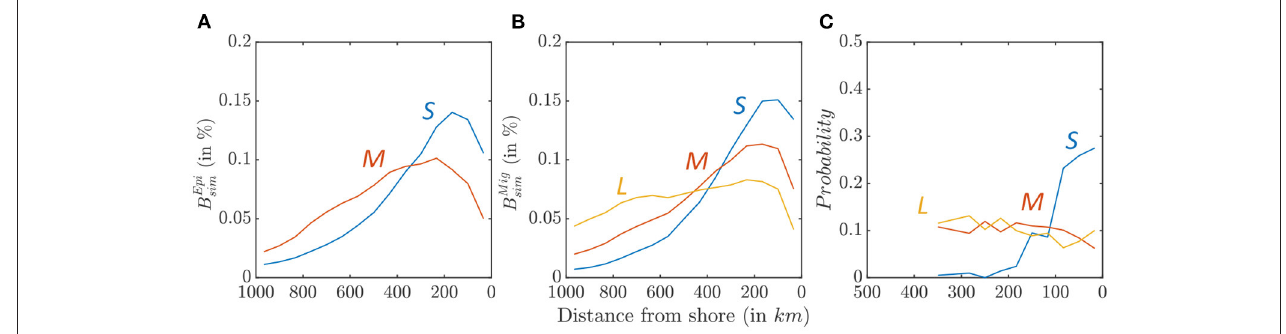
FIGURE 9 | Biomass density along a cross-shore section, for small (blue), medium (red), and large size (yellow) fish. (A) Relative distribution of simulated epipelagic biomass distribution B Epi sim . (B) Relative distribution of simulated migratory biomass distribution B Mig sim . (C) Observed relative distribution from OBIS species occurrence